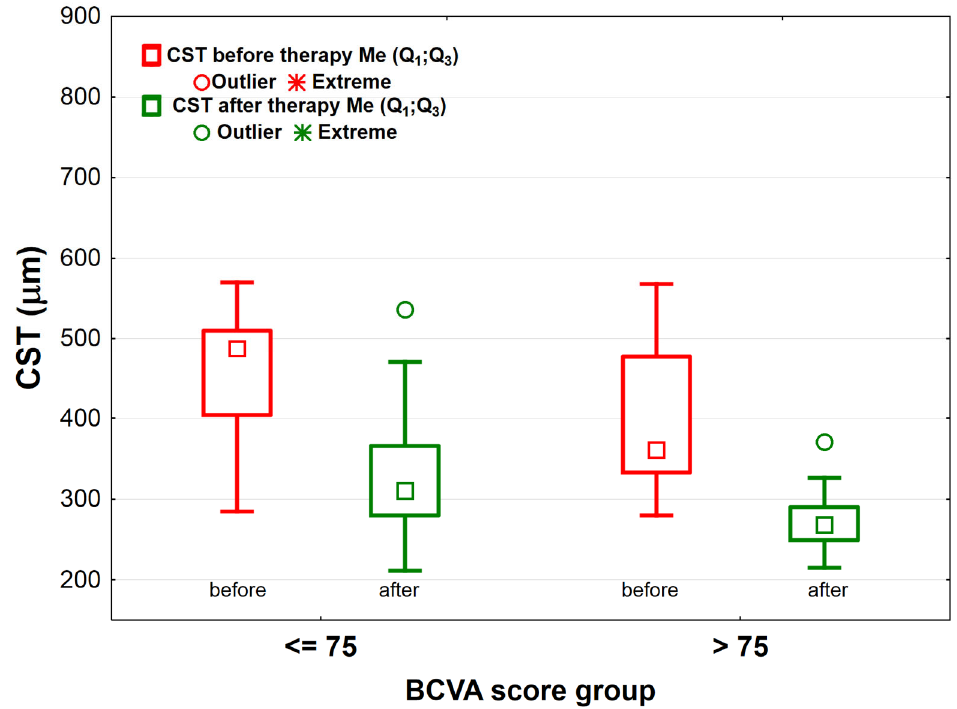
Figure 4. The macular CST (central subfield thickness) before and after bevacizumab treatment in the BCVA 75 group ( n = 41) and the BCVA >75 group ( n = 57) of patients with diabetic macular edema (DME). Legend: squares—mean the median; rectangles—range 25–75%; whiskers indicate the range of non ‐ outliers; circles indicate outliers; asterisks (*)—extreme values. We observed that total contrast leakage area, contrast leakage area in the far periphery and posterior zone after bevacizumab therapy was reduced in each BCVA score group ( p < 0.001 for both groups) (Table 6). Before the therapy, we found no statistically significant differences in total leakage area ( p = 0.757), leakage area in the far periphery ( p = 0.743) and in the posterior zone ( p = 0.572) between the BCVA score groups. However, after therapy, the total contrast leakage area, contrast leakage area in the far periphery and the posterior zone were significantly higher in the BCVA 75 group than in the BCVA >75 group ( p < 0.05 for all variables) (Table 6). The analysis of the results showed that total NPA, NPA in the far periphery, in the mid ‐ periphery and the posterior zone decreased in both BCVA score groups after bevacizumab therapy. We found no statistically significant differences between the BCVA 75 and BCVA >75 groups in NPA occurrence before and after bevacizumab treatment.